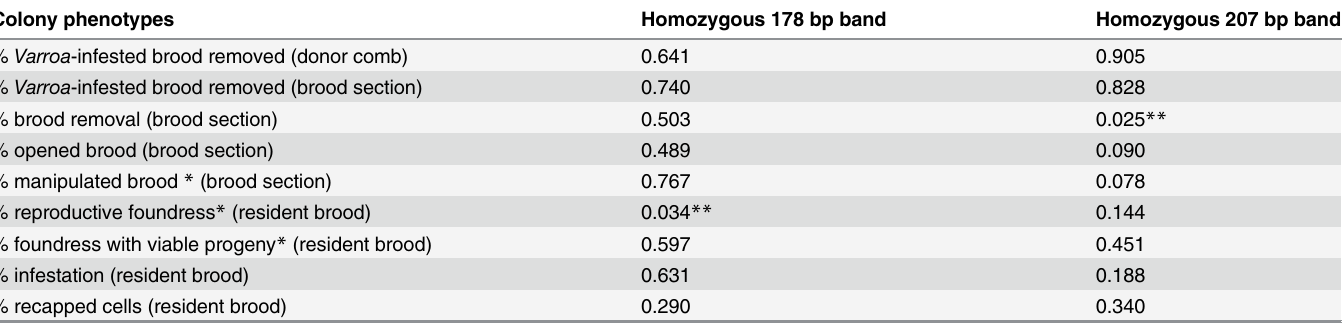
Table 3. P - value of associations between allele homozygosity and colony